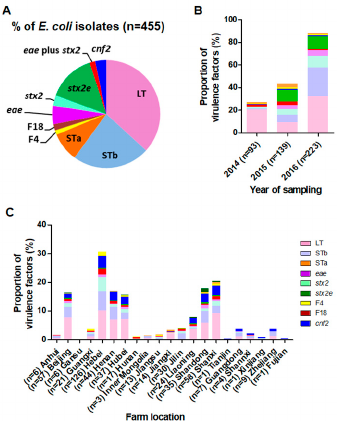
Figure 1. Frequency of virulence genes in E. coli isolates from pigs with diarrhea in China. ( A ) The occurrence of diarrheagenic virulence genes among the 455 E. coli isolates obtained from 2014 to 2016 in Chinese large-scale swine farms. Prevalence of virulence factors by ( B ) year of sampling and ( C ) sampling